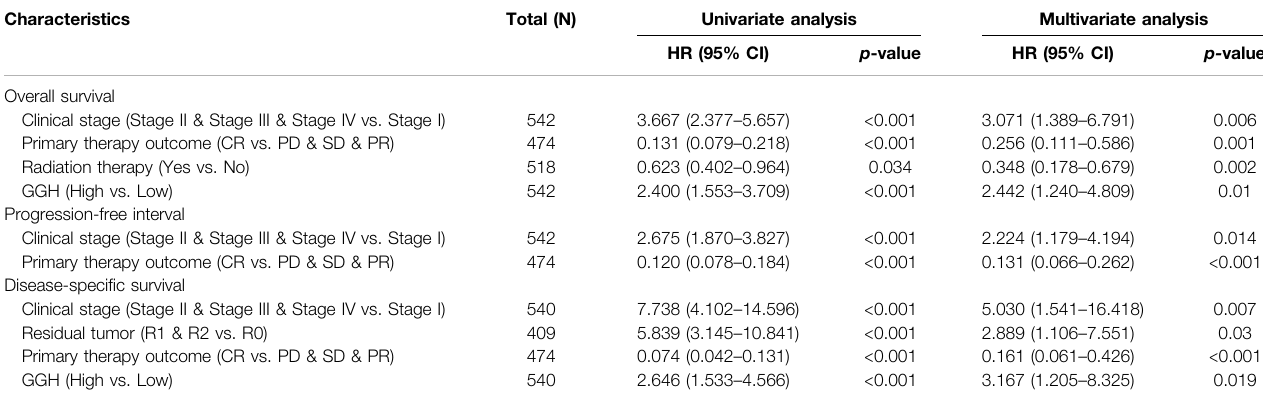
TABLE 3 | Associations of survival outcomes with clinicopathologic characteristics in TCGA patients by univariate and multivariate analyses.